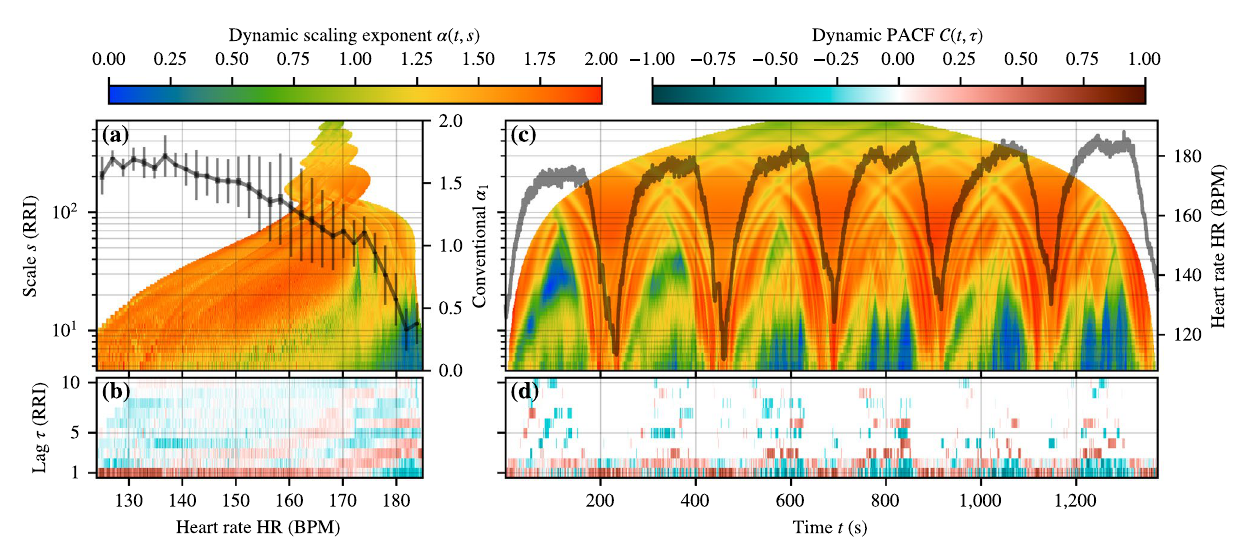
Figure 2. Aggregate beat-to-beat (RR) interval correlations as a function of heart rate for all subjects of group M. ( a ) Average values for α( t , s ) for each scale s (y-axis) and HR bin (x-axis). The solid line depicts the conventional short-range α 1 . ( b ) Average values for C ( t , τ) for each lag τ (y-axis) and HR bin (x-axis). In ( a , b ), the data is processed as in Fig. 1. ( c , d ) Similar to ( a , b ) but as a function of the relative HR. In ( c , d ), the data is processed as in Fig. 1, but with the distinction that the relative HR bin width is 0.001, the interpolation threshold is 0.005, and the bin width for the conventional short-scale exponent α 1 in ( c ) is 0.01.